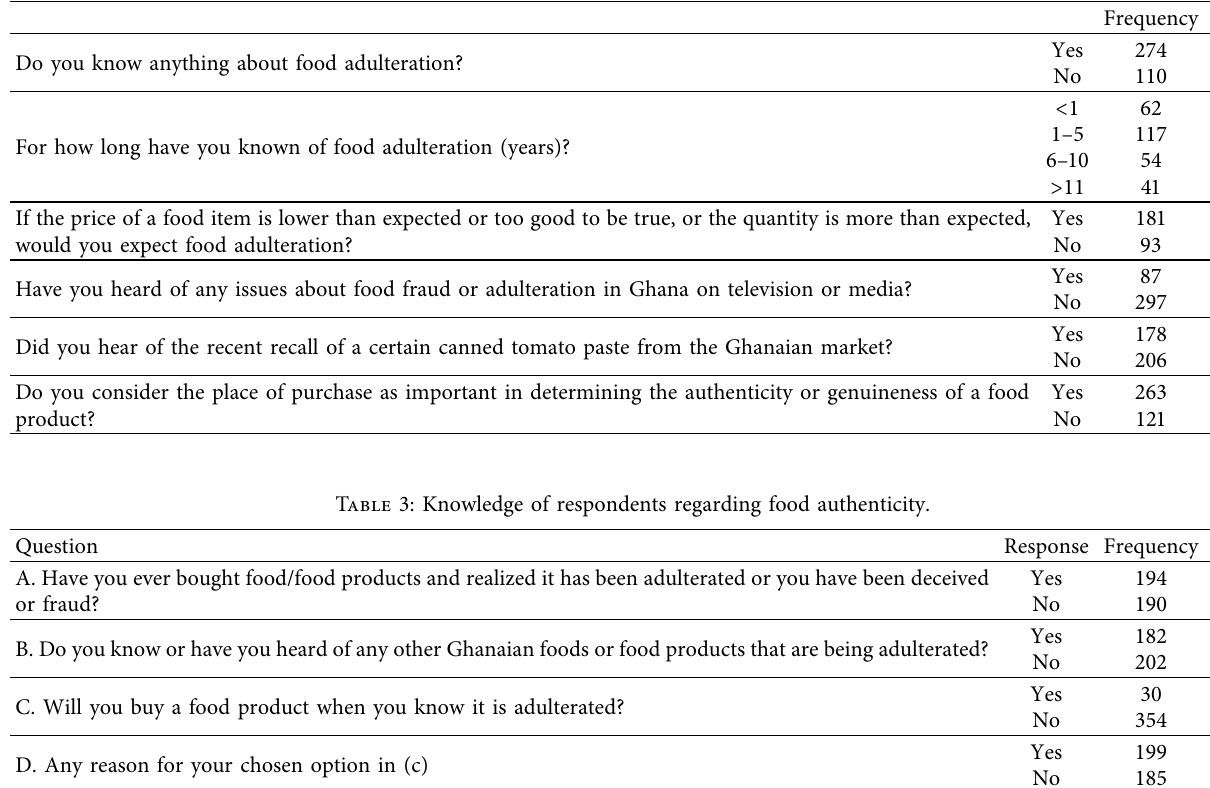
Table 2: Respondents’ knowledge about food adulteration or authenticity.